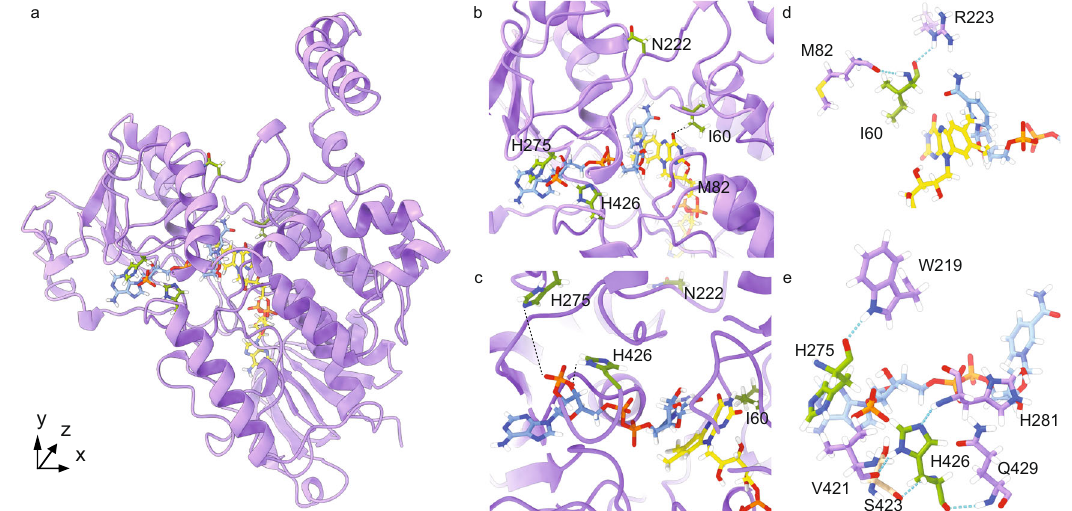
d Hydrogen bonding interactions for I60 are shown in light blue. e Hydrogen bonding interactions for H275 and H426 are described in light blue. tAncFMO1 – 5secondarystructureandresiduesareshowninpurple.FADandNADP + molecules are depicted in yellow and blue,